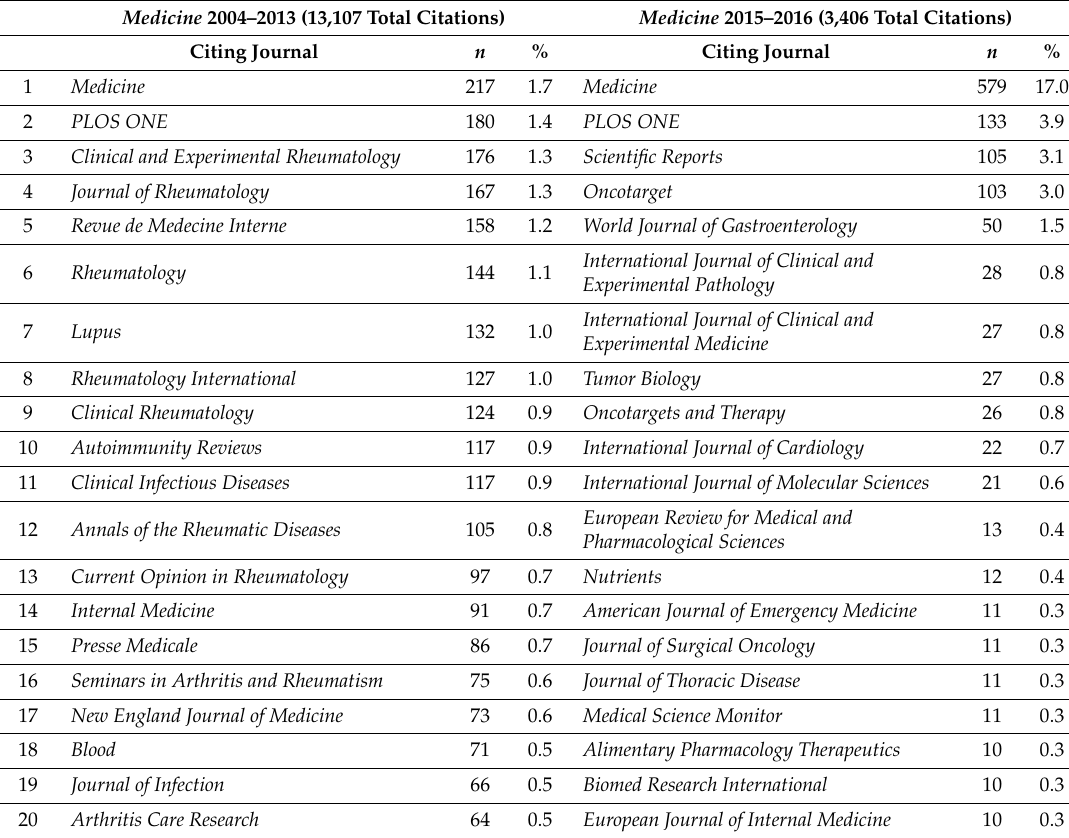
Table 6. The 20 most common citing journals for Medicine (pre- and post-mega-journal transition). Titles in bold are common to both